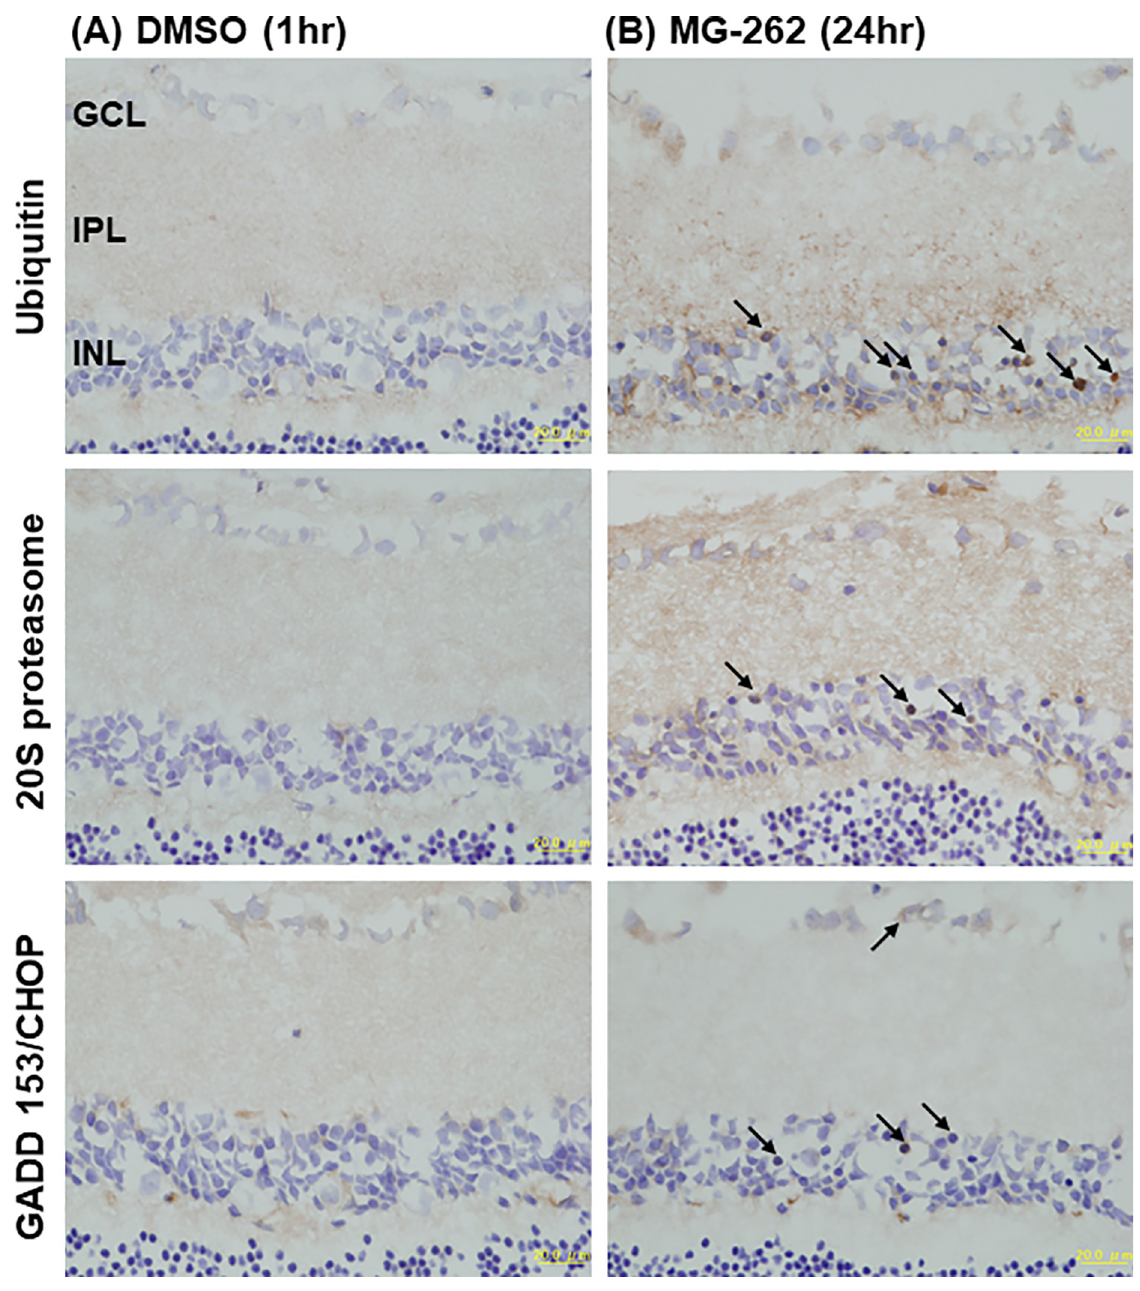
Fig 7. Increased ubiquitin-positive immunohistochemical staining in the retina following intravitreal injection of MG-262. Each photograph shows the representative image of cross-sectioned retina following intravitreal injection of vehicle (A, 50% DMSO in distilled water) and MG-262 (B, 0.1 nmol/eye). Eyes were enucleated 1 and 24 hrs following injection and the retina was subjected to immunohistochemical staining using antibodies against ubiquitin (upper), 20S proteasome subunit (middle) and GADD153/CHOP (lower). Arrows show representative cells positively stained with each antibody. Each scale bar shows 20 μ m. GCL: ganglion cell layer; IPL: inner plexiform layer; INL: inner nuclear layer.